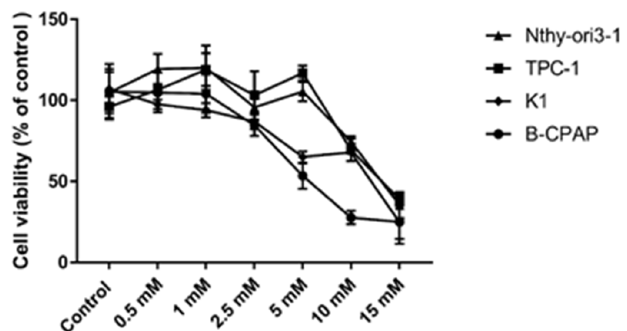
Figure 1. Viability of cells treated with vitamin C (0.5–15 mM) for 48 h analyzed by MTT assay. Data are expressed as % of the untreated cells (control) ± SD. All experiments were performed three times independently. Table 1. Concentration of vitamin C able to induce 50% of cell death in PTC-derived and control cells.